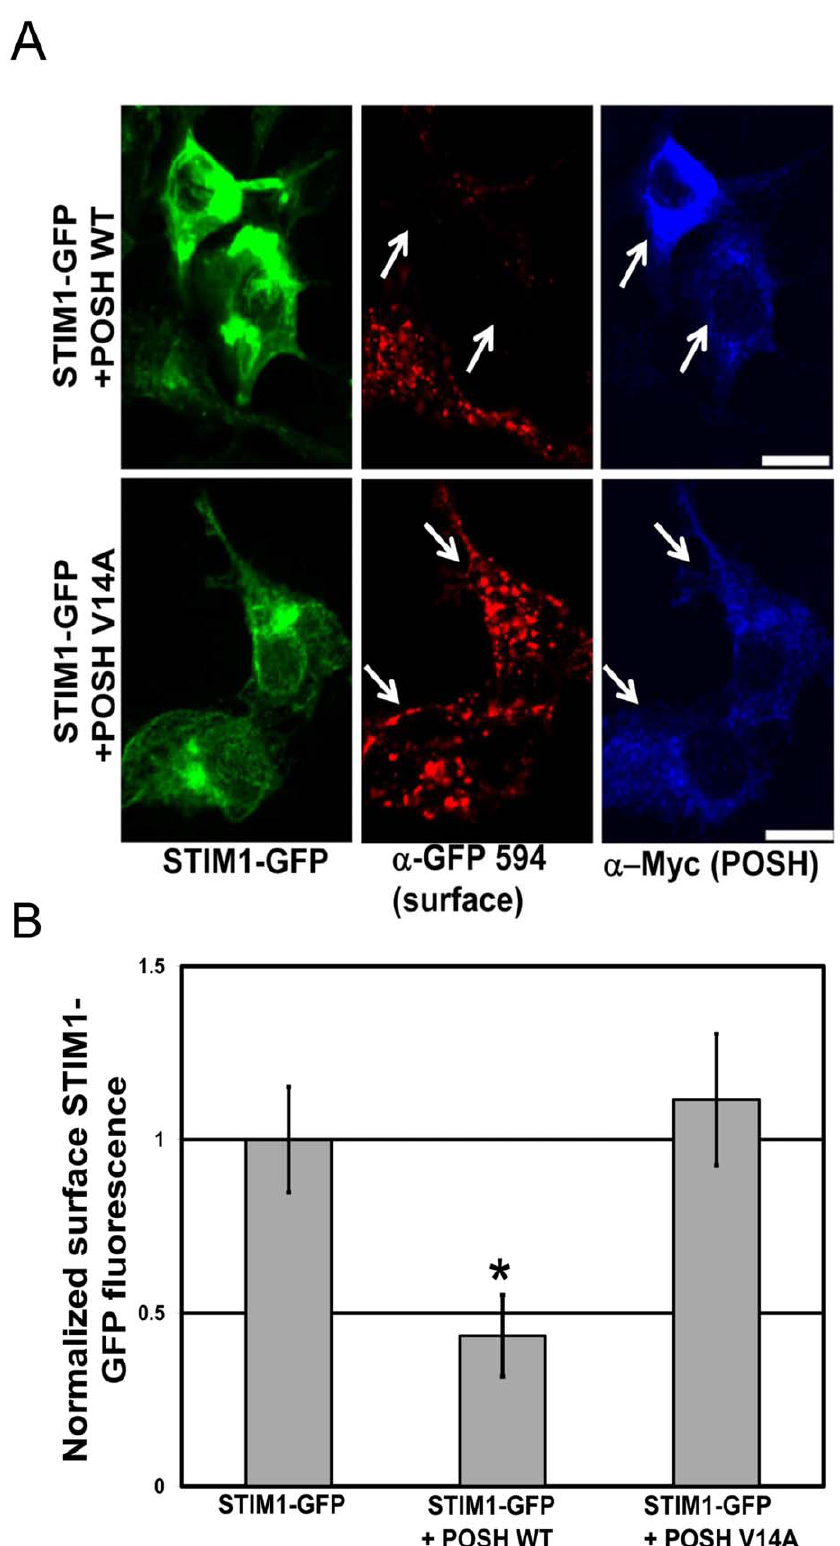
Figure 5. Overexpression of the E3 ligase POSH decreases surface STIM1-GFP levels. (A) HEK293 cells co-expressing STIM1-GFP (green), and WT or the RING-finger mutant (V14A) myc-tagged POSH constructs were live-labeled with a -GFP-Alexa 594 conjugated antibodies (red) prior to fixation, permeabilization and immunolabeling with a -Myc antibodies (blue). Co-expression of WT POSH dramatically reduced surface STIM1-GFP levels while the RING-finger mutant POSH V14A had no effect on STIM1-GFP surface levels. Representative max z-projected confocal images are depicted. Scale bars, 10 m m. (B) Bar graph depicting the quantification of the STIM1-GFP surface levels in STIM1-GFP alone, or STIM1-GFP plus WT or